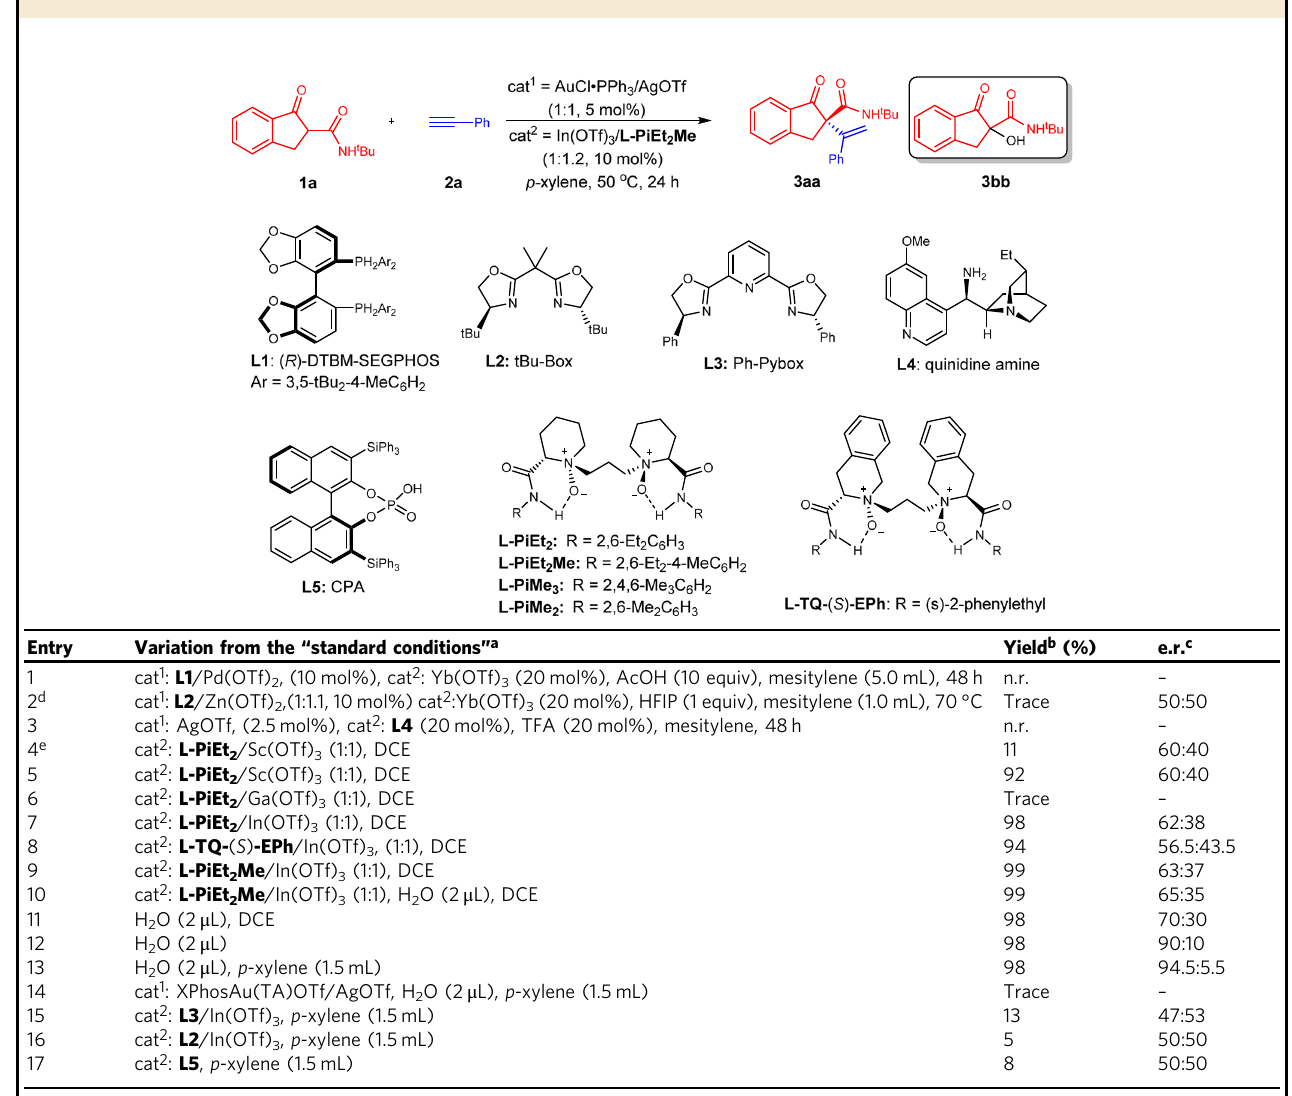
Table 1 Optimization of the reaction